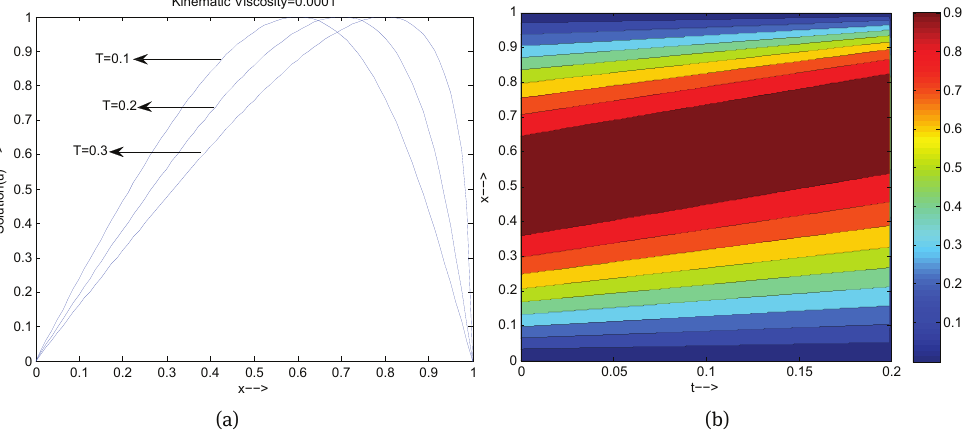
Fig. 13: Physical behavior of numerical solutions for Example 1 in 2D and contour form for ν = 0.0001 at different times with Δx = 0.0125 and Δt = 0.001 .